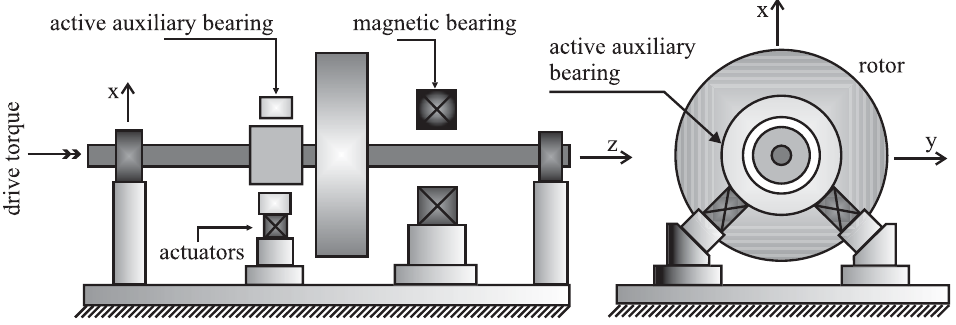
Fig. 1. Active rotor-auxiliary bearing